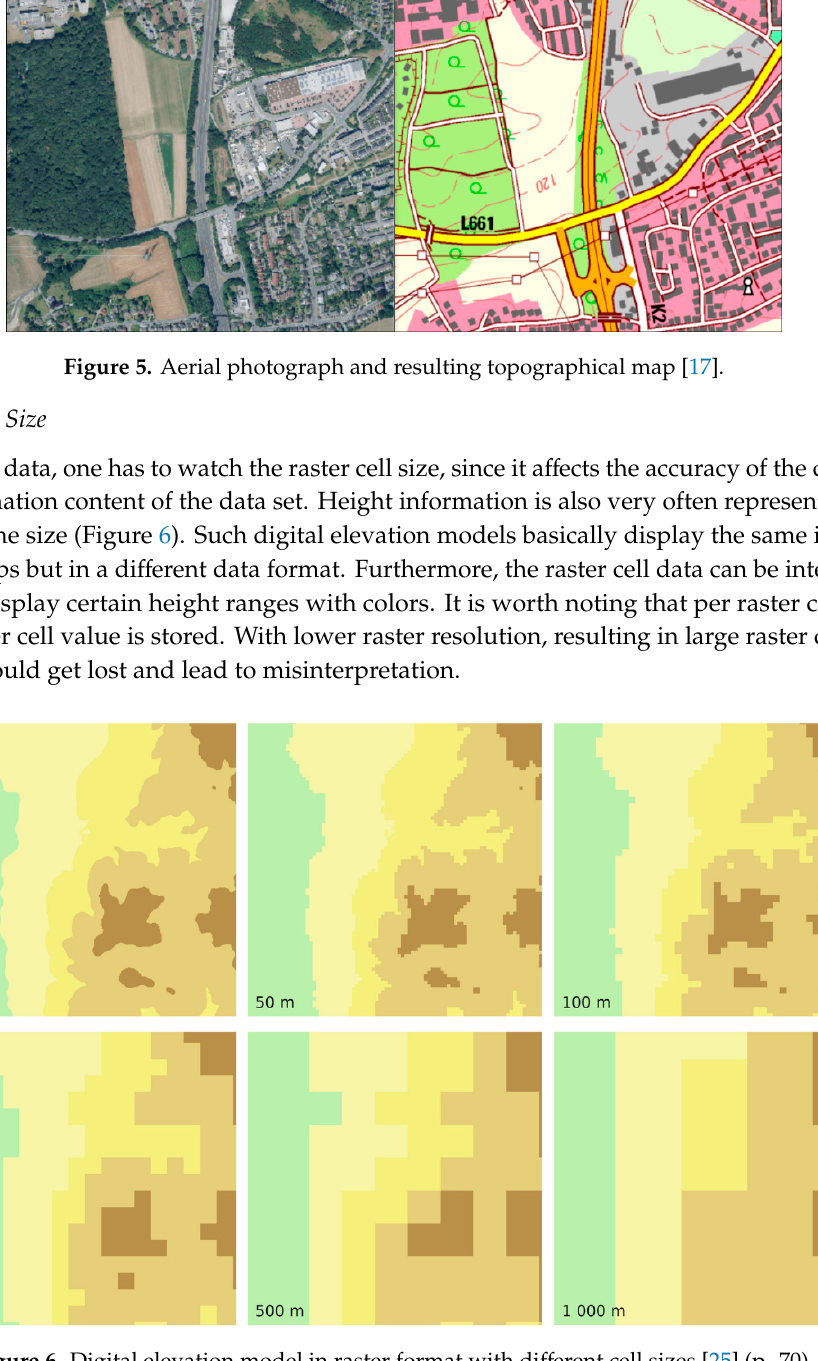
Figure 6. Digital elevation model in raster format with different cell sizes [25] (p. 70).